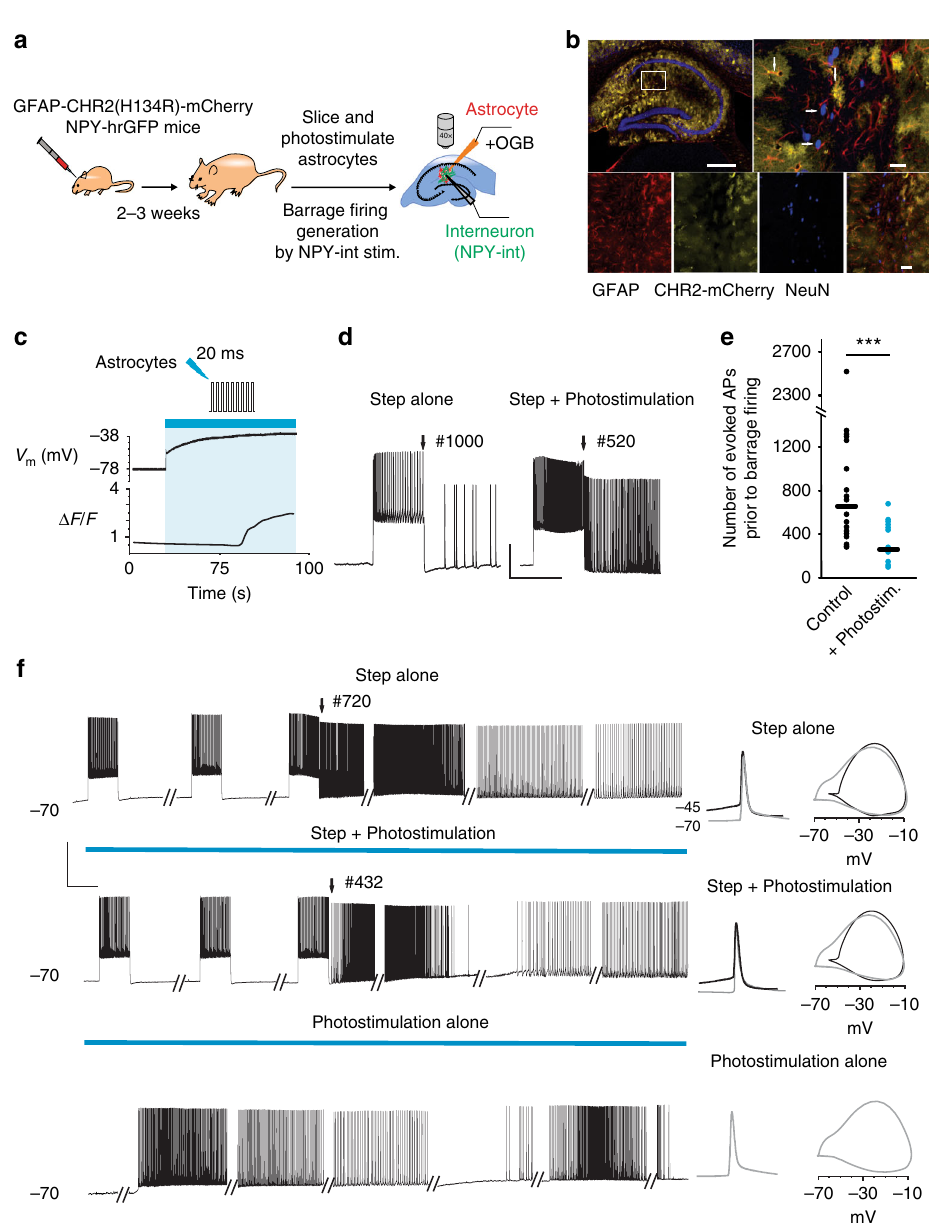
Fig. 5 Optogenetic activation of astrocytes enhances barrage fi ring induction. a Schematic of experiment protocol. Author T.D. drew the mice and syringe. b Image showing co-localization (yellow) of ChR2 – mCherry (green) with astrocytes (anti-GFAP, red) but not with neurons (anti-NeuN, blue) in CA1 area. Note that ChR2 is not expressed in all astrocytes (i.e., red instead of yellow). Scale bars, 600 μ m top left, 30 μ m top right and 40 μ m bottom right. c Example of recording from a ChR2-mCherry-infected astrocyte and the observed membrane potential depolarization and increase in Ca 2 + transients in response to photostimulation. d Facilitation of barrage fi ring generation in an example recording with combined step depolarization and photostimulation of ChR2-mCherry-infected astrocytic network (right trace) compared to control condition (i.e., in response to step depolarization alone, left trace). The number of spikes required for barrage fi ring induction is shown on top of the traces. Scale bars, 30 mV, 1 s. e Comparison of the number of evoked action potentials (i.e., step depolarization) required to induce barrage fi ring with and without photostimulation ( n = 18 from 10 mice; paired t test, *** p = 0.001). f Barrage fi ring induction using three different protocols in the same interneuron. Similar results were observed in three other neurons ( n = 4/12 from 8 mice; no barrage fi ring in response to photostimulation alone in n = 8/12). Phase plots of barrage fi ring spikes (right, gray) are similar for all conditions and readily distinguishable from current-evoked spikes (black). Scale bars, 50 mV, 1 s. Data are represented as mean ±